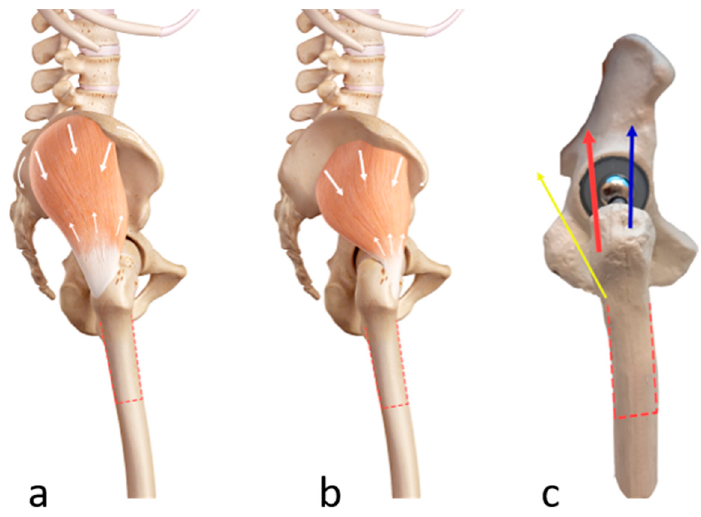
Figure 2. ( a ). Anatomy of the gluteus medius muscle: the gluteus medius muscle originates on the lateral surface of the ilium and attaches to the posterior and lateral part of the superior aspect of the greater trochanter. ( b ). Anatomy of the gluteus minimus muscle: the gluteus minimus originates on the lateral surface of the ilium and attaches at the anterolateral aspect of the greater trochanter. ( c ). Illustration of the direction of the forces applied by the gluteus medius (red) and minimus (blue) muscles on the osteotomized fragment. Contraction of the gluteus medius muscle produces an abduction force to the osteotomized trochanter fragment, whereas contraction of the gluteus minimus muscle produces an abduction and a lesser internal rotation force to the osteotomized trochanter fragment. Together, activation of these two muscles can cause cranial dislocation of the trochanter fragment. The external rotators also attach to the osteotomized fragment and produce an external rotation force (yellow); however, this force is lower than the force of the other two muscles and is not relevant for the trochanteric escape.